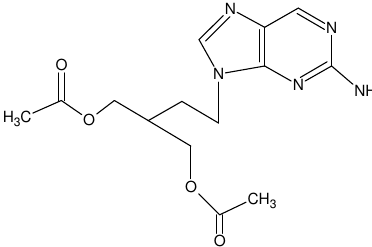
Figure 1. Chemical structure of famciclovir.